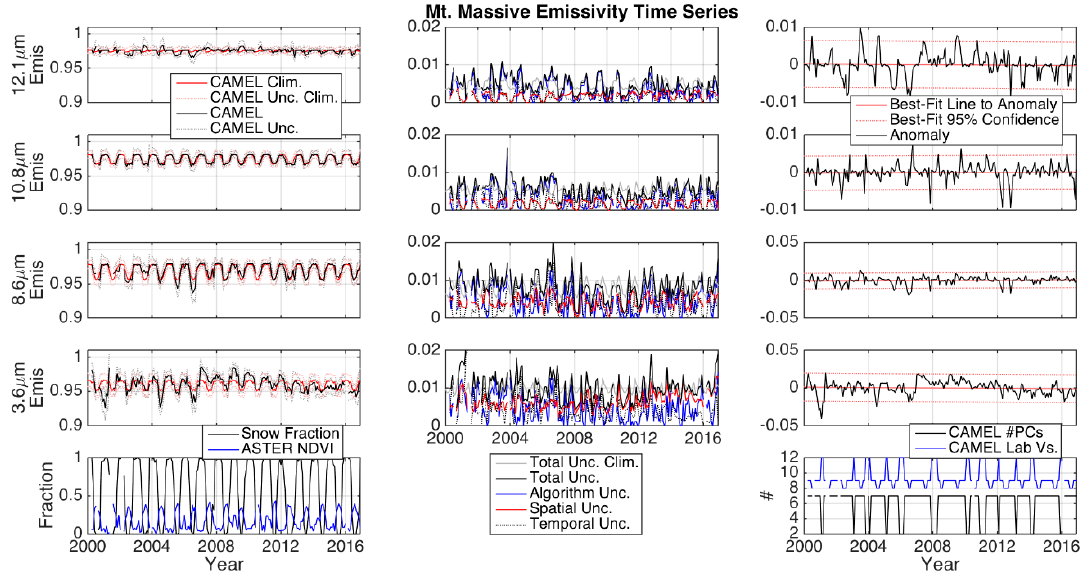
Figure 7. Same as Figure 4 except for the Mt. Massive, Colorado Rocky Mountain partially snowy, mountainous site.